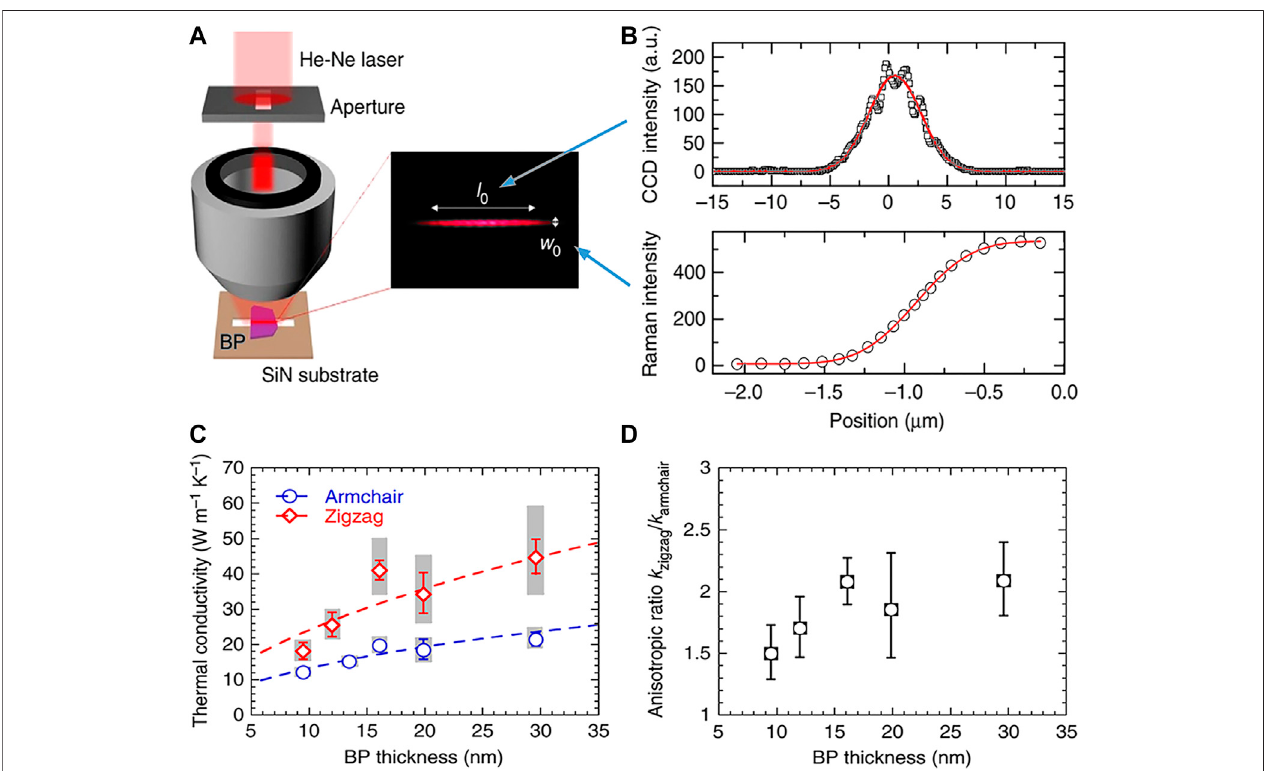
FIGURE2|(A) Thediagramofexperimentalprocedures. (B) Thelengthwisepro fi leandtheknife-edge-measuredwidthwiseintegratedpro fi leofthelaserfocalline, corresponding to a Gaussian function. (C) The measured thermal conductivities of multiple BP fi lms along AC and ZZ directions, respectively. Dashed lines denote the theoreticalmodelingresults. (D) Theanisotropicratioofthermalconductivityfordifferentphosphorusthickness.Reproducedfrom(Luoetal.,2015)withpermissionfrom Nature Publishing Group.